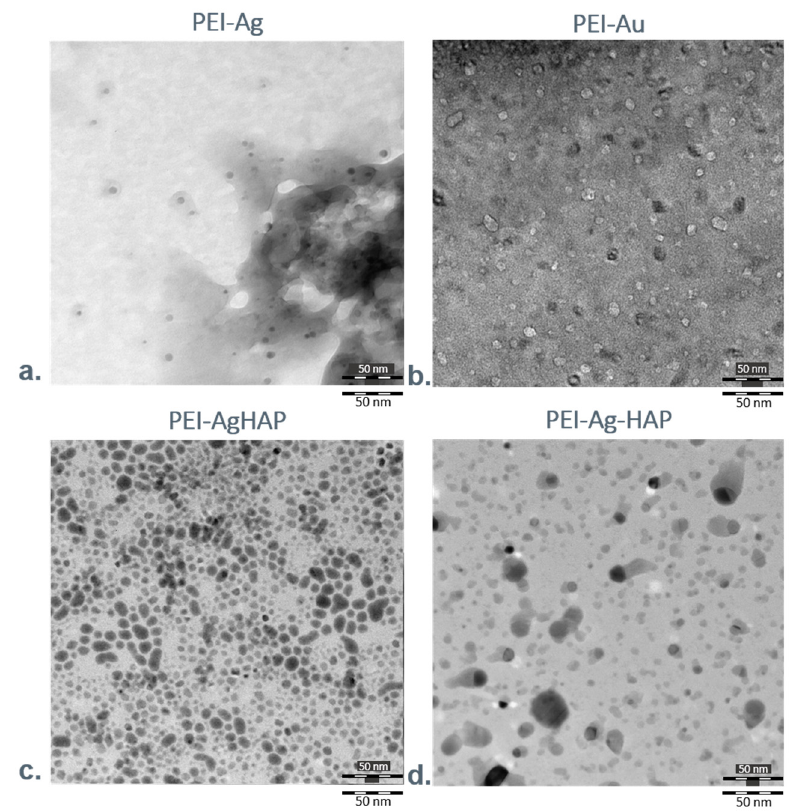
Figure 6. Transmission Electron Microscopy photographs showing the surface of examined membranes. Key to symbols: ( a ) the surface of the polyethyleneimine membrane incorporating AgNPs (PEI-Ag); ( b ) the surface of polyethyleneimine membrane incorporating AuNPs (PEI-Au); ( c ) the surface of polyethyleneimine incorporating AgNPs|hydroxyapatite (PEI-Ag|HAP); ( d ) the surface of hydroxyapatite mixed with polyethyleneimine incorporating AgNPs (PEI-Ag-HAP).